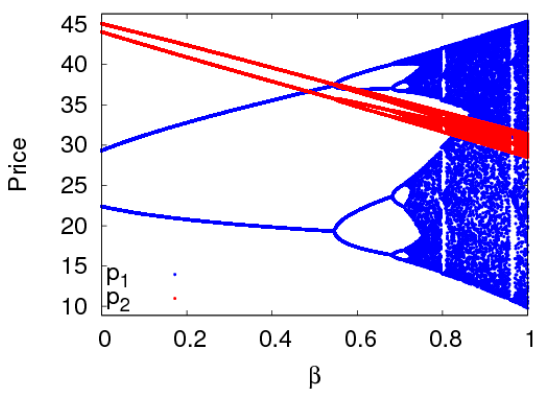
Figure 12. The bifurcation diagram of the dynamic system (6) with β changing when a 1 = 0.013, a 2 = 0.008.